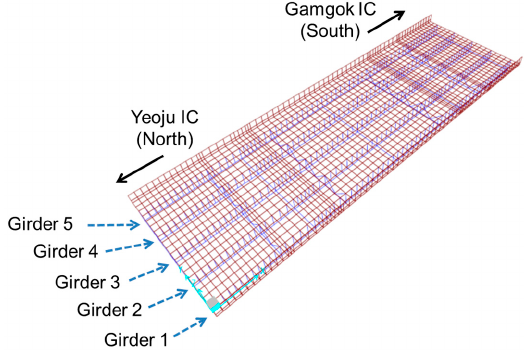
Figure 4. FE model of Samseung Bridge developed using SAP2000. IC, Interchange.